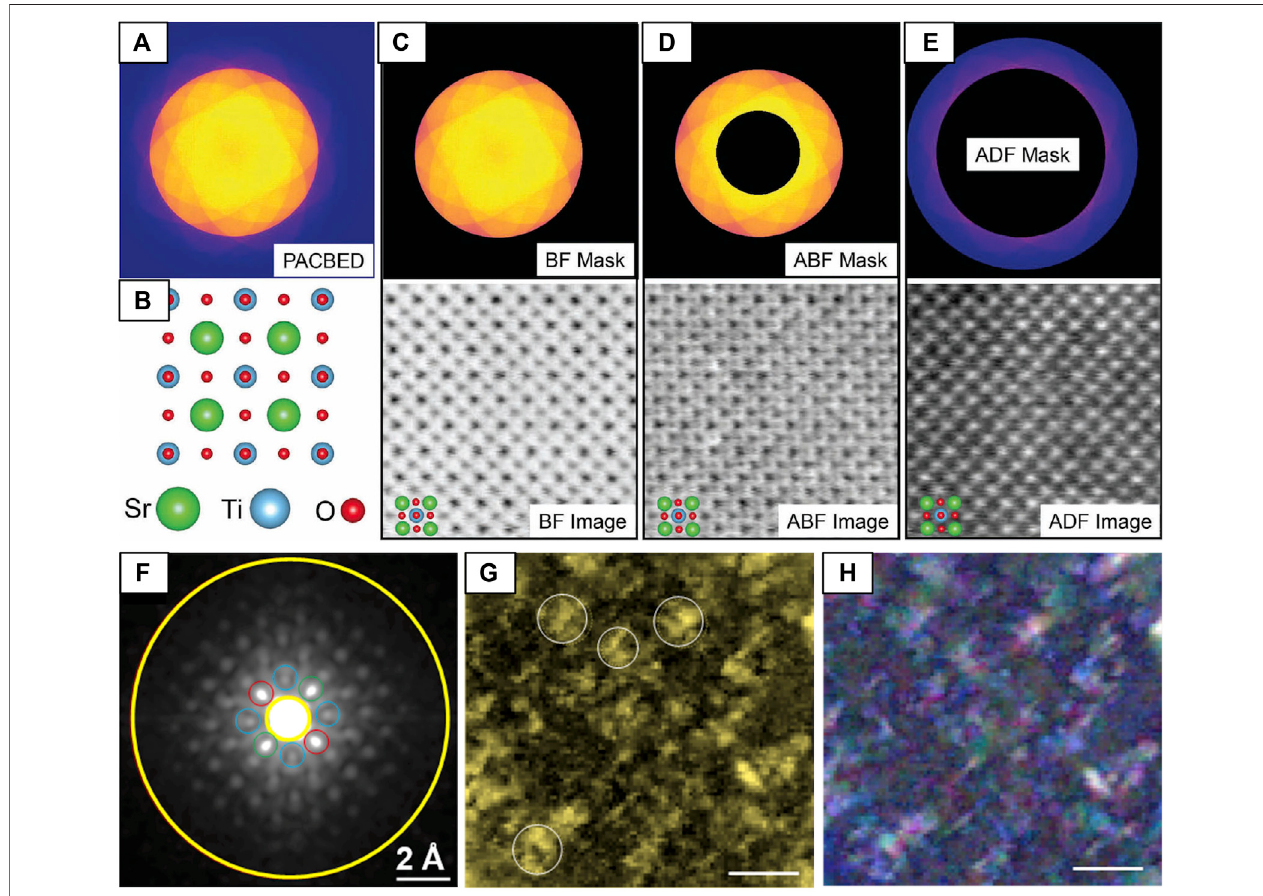
FIGURE13| Using4D-STEMdatasetstoreconstructvirtualimages (A – E) ofSrTiO3atatomic-resolutionand (F – H) ofseverelatticedistortionsinanHEAusingthe differenceCepstrum(dCp)transformtoselectonlydiffuseelectronscattercontributions. (A) A4D-STEMPACBEDdatasetacquiredfromSrTiO 3 [001]andthe (B) crystal structure of SrTiO 3 [001]. Masks (top row) can be applied to the 4D dataset to produce (C) BF (D) ABF and (E) ADF images, reproduced from reference (Levin et al., 2020b). The (F) (dC p ) averaged across the scanned region. A (G) virtual-image formed from the total diffuse scattering signal integrated over yellow annulus in (F) andan (H) compositevirtual-imageoftheblue,green,andredsignalsinthedC p showingthecomplexstructuraldistortionsoftheHEA.ScalebarsinGandHare40 nm, reproduced from (Shao et al. 2021).